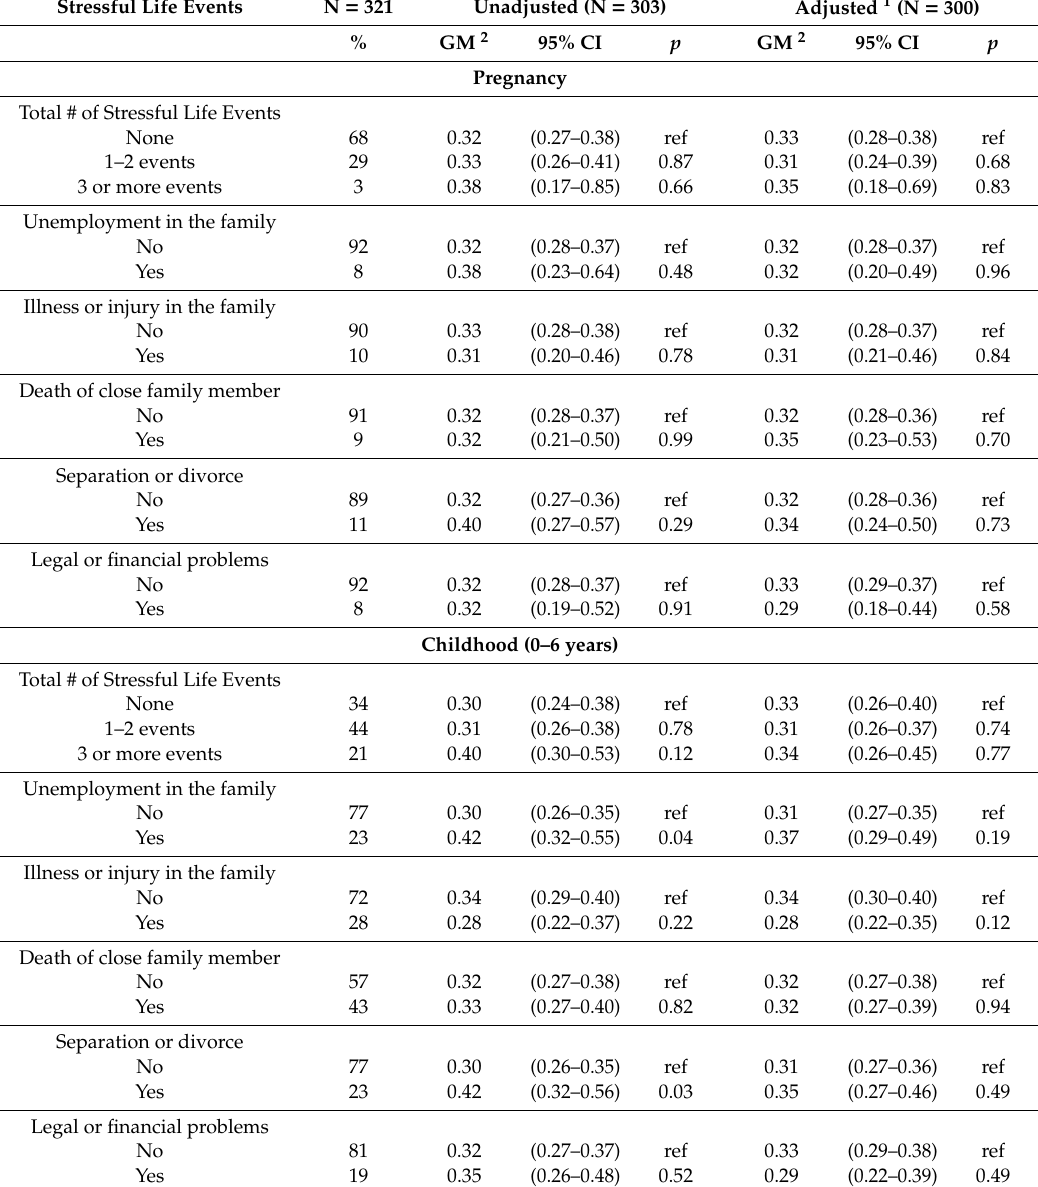
Table 4. Stressful Life Events in Relation to Urinary Cotinine Levels ( µ g / g